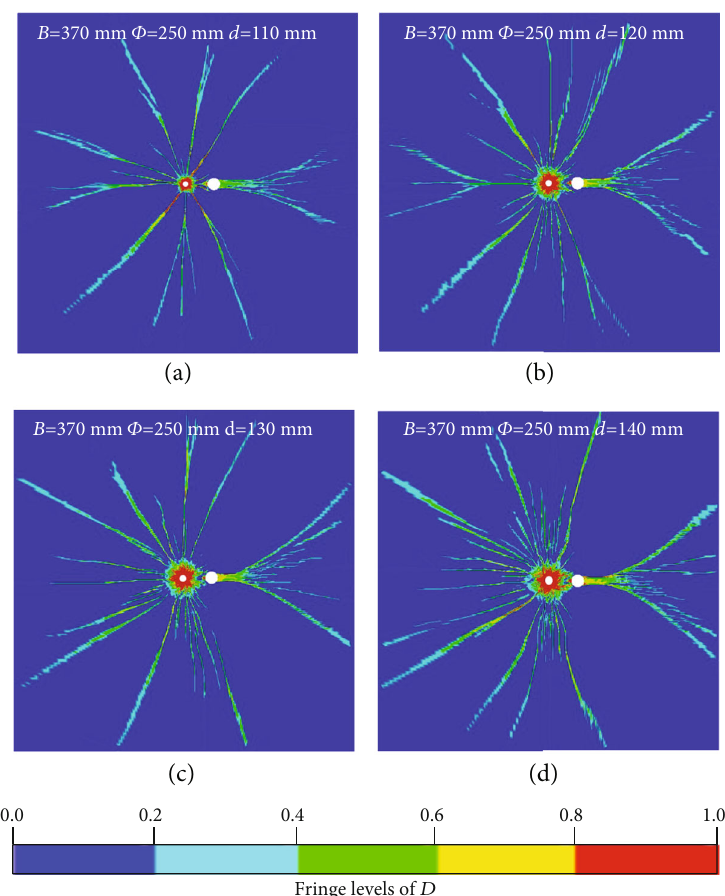
Figure 8: Overall damage of prime cut blasting under di ff erent diameters of the charge hole: (a) scheme 5, (b) scheme 11, (c) scheme 12, and (d) scheme